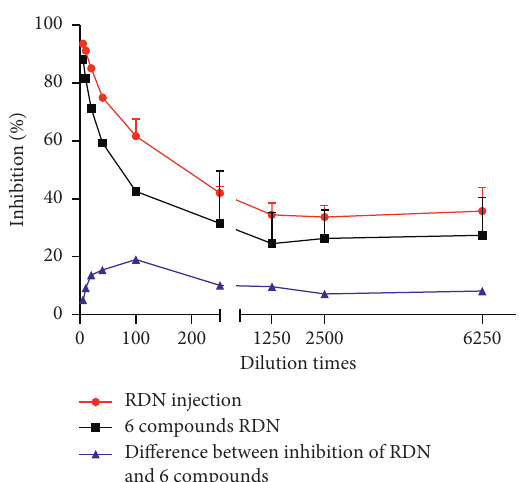
Figure 7: The inhibition ratio of RDN injection and 6 active components combination with different dilution times and the difference between inhibition of RDN and 6 components